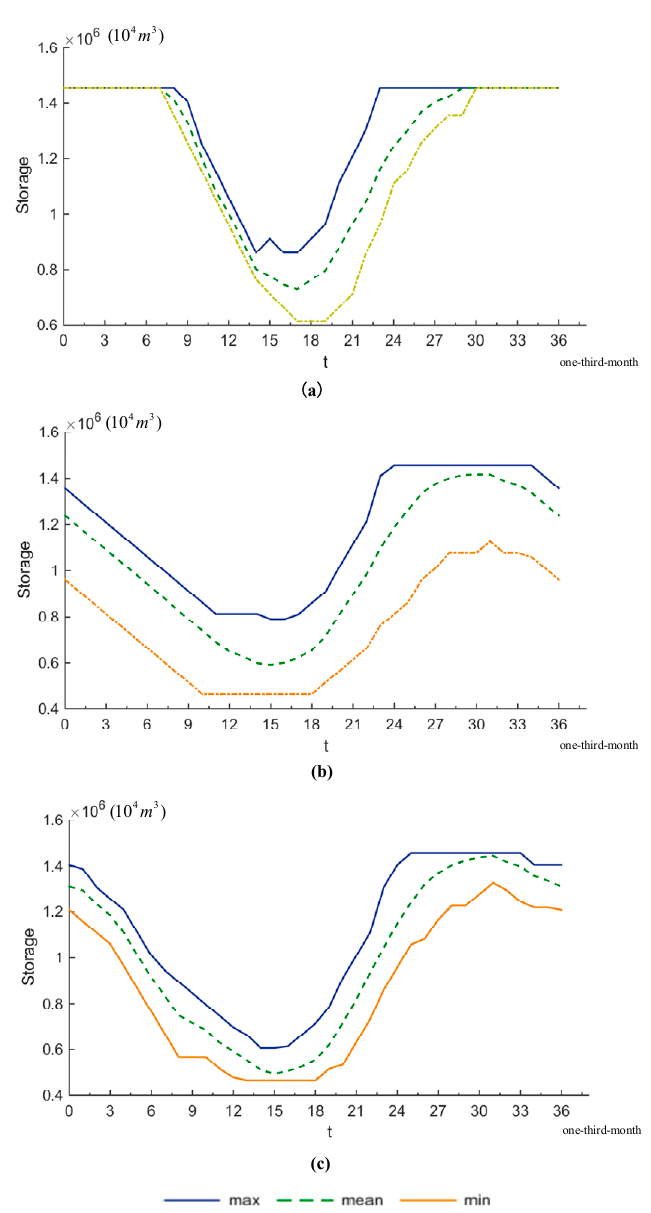
Figure 3. Max, mean, and min storage trajectory for 1449 years of simulations.